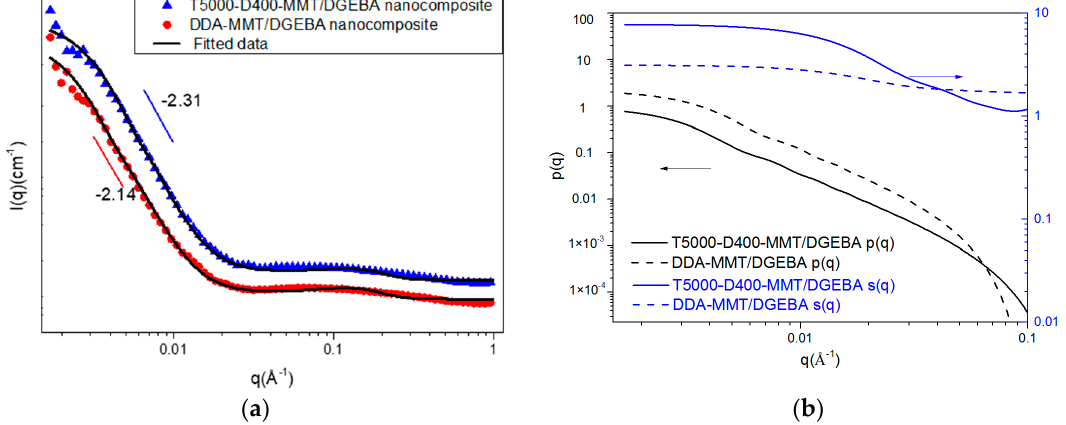
10 of 17 Figure 6. TEM images of epoxy matrix nanocomposites reinforced by Na-MMT ( a1 , a2 ), T5000-D400- MMT ( b1 , b2 ) and DDA-MMT ( c1 , c2 ) at 3 wt % clay loading. Even though the basal distance and layer number could be obtained in the TEM images, the results were limited to some local information on the surface of samples due to the small field of vision and the strong decay of electrons in polymer. Therefore, in this work, SANS measurement was performed on nanocomposites reinforced by DDA-MMT and T5000-D400-MMT to obtain a quantitative description of the size and aggregation of scatters in nanocomposites. As shown in Figure 7, both plots of DDA-MMT and T5000-D400-MMT reinforced epoxy presented linear regions at low-q range with slopes of − 2.14 and − 2.31. According to the power law mentioned in Section 3.2, the scatters in DDA-MMT/DGEBA nanocomposite had smaller size than that of the T5000-D400-MMT/DGEBA nanocomposite. Owing to the same filler loading, it can be inferred that the DDA-MMT had a better dispersion in DGEBA epoxy than that of T5000-D400-MMT. Afterwards, the scattering data were fitted based on the sandwich structure model. The fitted lines in Figure 7a followed the data well over the entire q range. The contributions of form and structure factors are shown in Figure 7b. The results calculated are presented in Table 4. The scatter length density values were obtained by Equation (5), and the volume fraction of MMT was calculated based